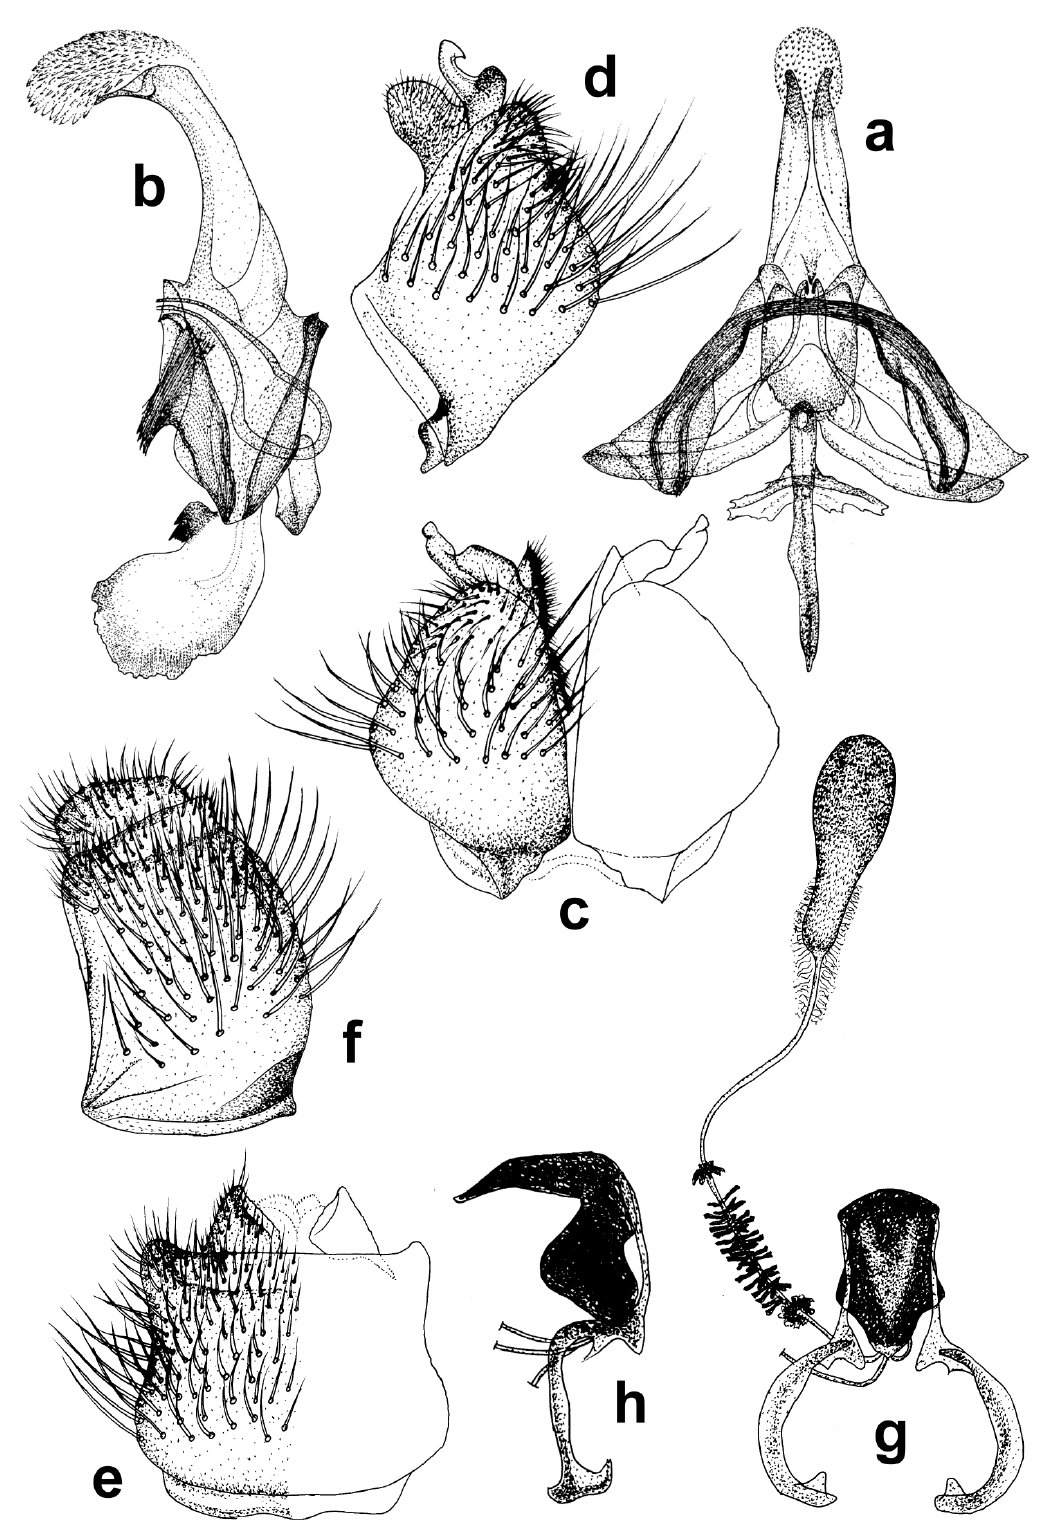
Fig. 43. Protypusia striata (Báez, 1982) gen. et comb. nov. a . Epiphallic complex ventral. b . Epiphallic complex lateral. c . Gonocoxite ventral. d . Gonocoxite lateral. e . Epandrium dorsal. f . Epandrium lateral. g . Female genitalia ventral. h . Female genitalia